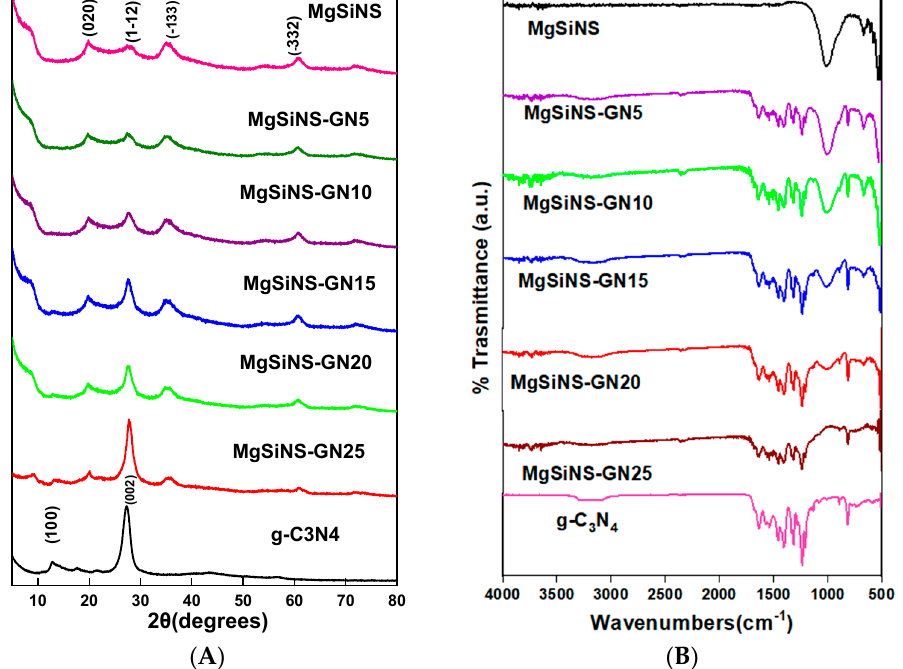
Figure 1. ( A ) XRD patterns and ( B ) FT − IR spectra of synthesized samples. Table 1. BET surface area and the pore size, pore volume, and crystal sizes of MgSiNS and g − C 3 N 4 phases.